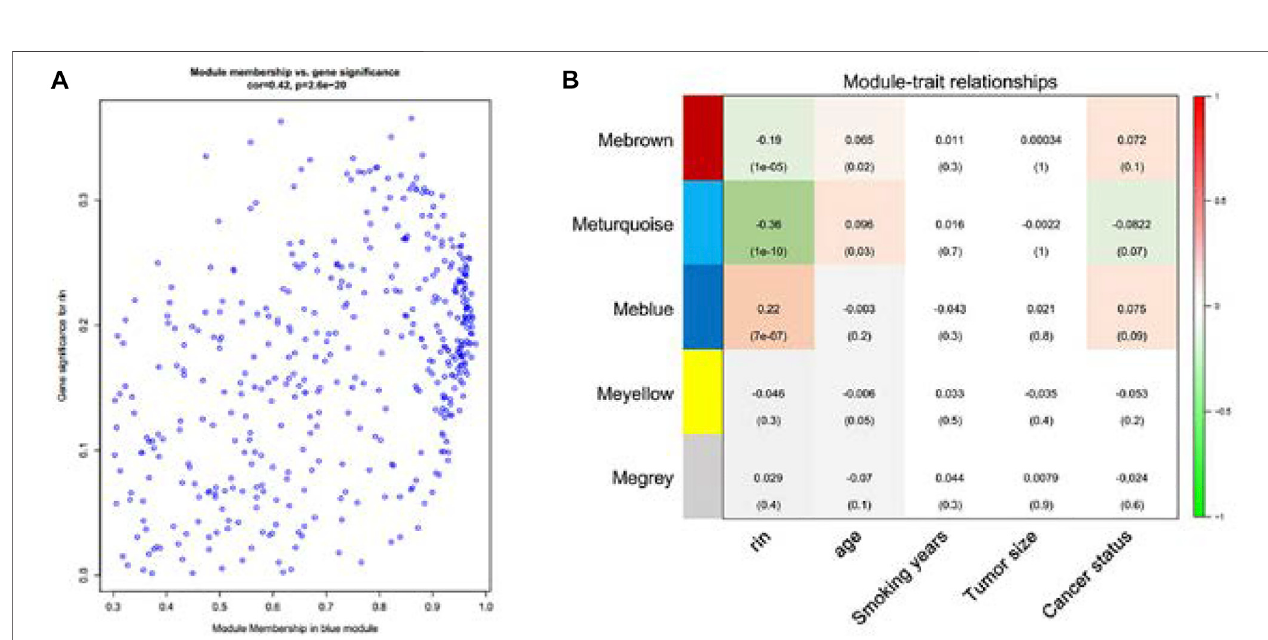
FIGURE4| Scatterplotofgenesigni fi cance(GS)forlungcancerstatusvs.modulemembership(MM)inthebluemodule (A) .Thereisahighlysigni fi cantcorrelation betweenGSand MMinthebluemodule.Correlationofgeneco-expression moduleswithclinicaltraitsinthetraining cohort( n =196). Bluemoduleisstronglycorrelated with early lung cancer, so the blue module was chosen to be further analyzed (B) .